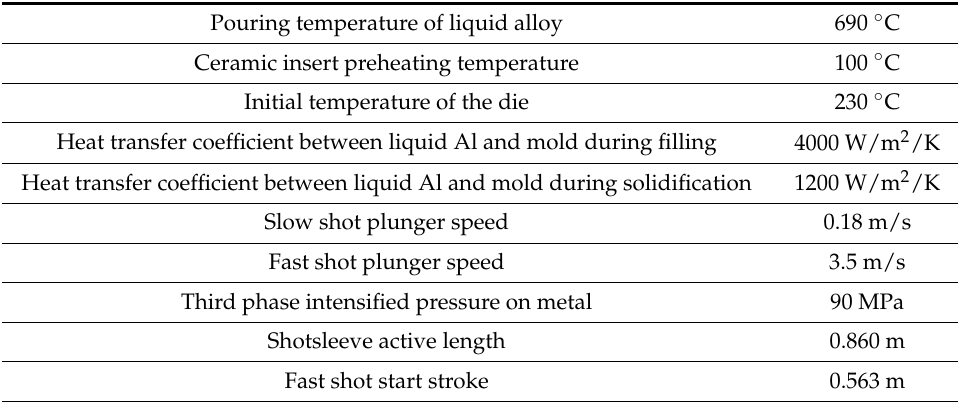
Table 4. CFD simulation